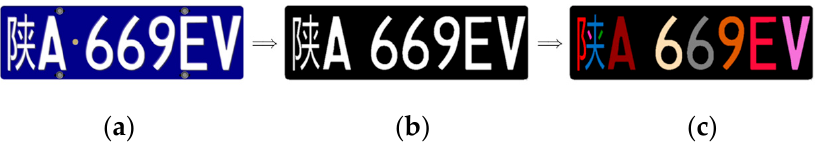
Figure 18. The example of traffic signs. ( a ) original image. ( b ) binary image. ( c ) component labeling.